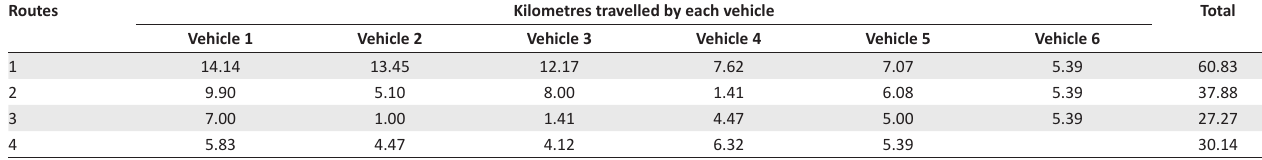
TABLE 4: Current distance (kilometres) and fuel consumption per route for the real problem. Routes